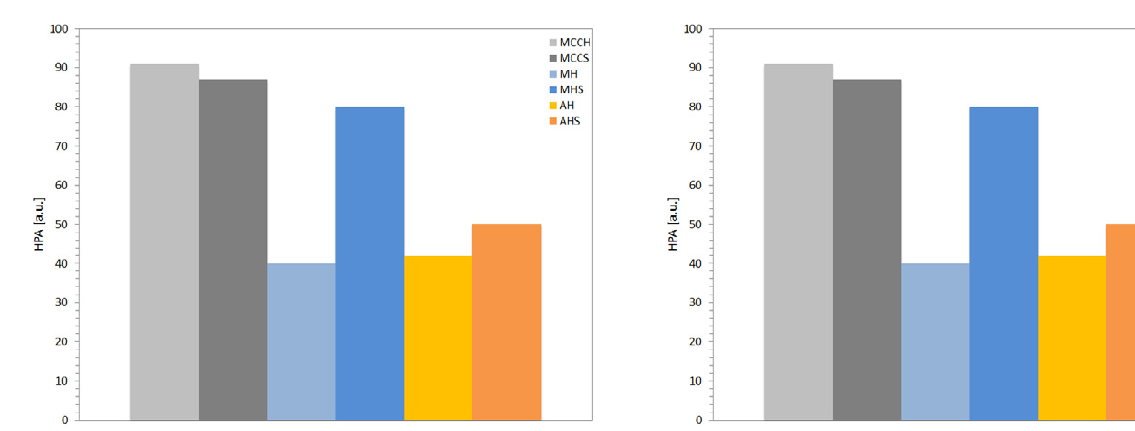
Fig. 6 Changes in hydroxyl peak area (HPA) for unmodified and modified MCC samples after air-drying (MCC, MH, AH) and ov- en-drying (MCCS, MHS, AHS)